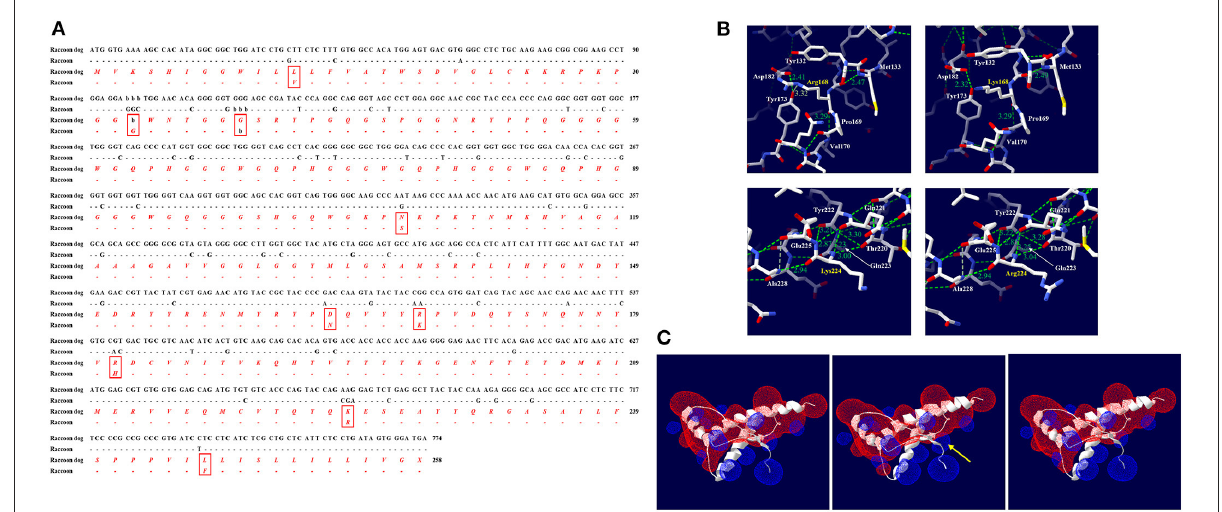
FIGURE4 Comparison of the ORF of the PRNP gene between raccoon dogs and raccoons and in silico evaluation of the impact of raccoon-specific amino acid substitutions on raccoon dog PrP. (A) The black text indicates nucleotide sequences, and the red and italic texts indicate amino acid sequences. (-: identical nucleotide or amino acid to raccoon; b: nucleotide or amino acid deletion; X: stop codon) (B) Hydrogen bond analysis according to substitutions by the Swiss-PdbViewer program. The upper left panel indicates raccoon dog PrP with the R168 allele. The upper right panel indicates raccoon dog PrP with the K168 allele. The lower left panel indicates raccoon dog PrP with the K224 allele. The lower right panel indicates raccoon dog PrP with the R224 allele. The green dotted lines indicate hydrogen bonds. The green numbers indicate the distance of the hydrogen bonds. (C) Electrostatic potential prediction according to substitutions by the Poisson-Boltzmann equation in the Swiss-PdbViewer program. The left panel indicates the electrostatic potential of wild-type raccoon dog PrP. The middle panel indicates the electrostatic potential of raccoon dog PrP with the R168K substitution. The right panel indicates the electrostatic potential of raccoon dog PrP with the K224R substitution. Positive potentials are drawn in blue. Negative potentials are drawn in red. The yellow arrows highlight remarkable electrostatic potential changes compared with the wild-type raccoon dog